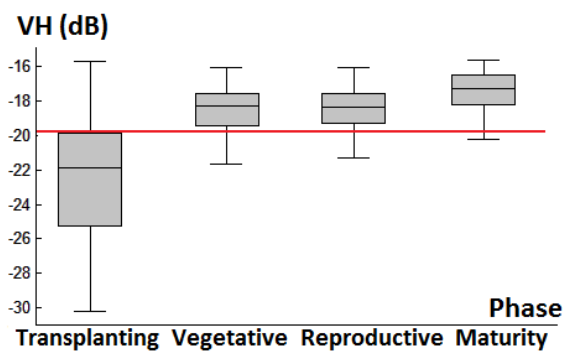
Figure 6. Distributions of development phases vs VH backscattering coefficients. The data are training data. At about -20dB, the transplanting phase is separated from other three phases.